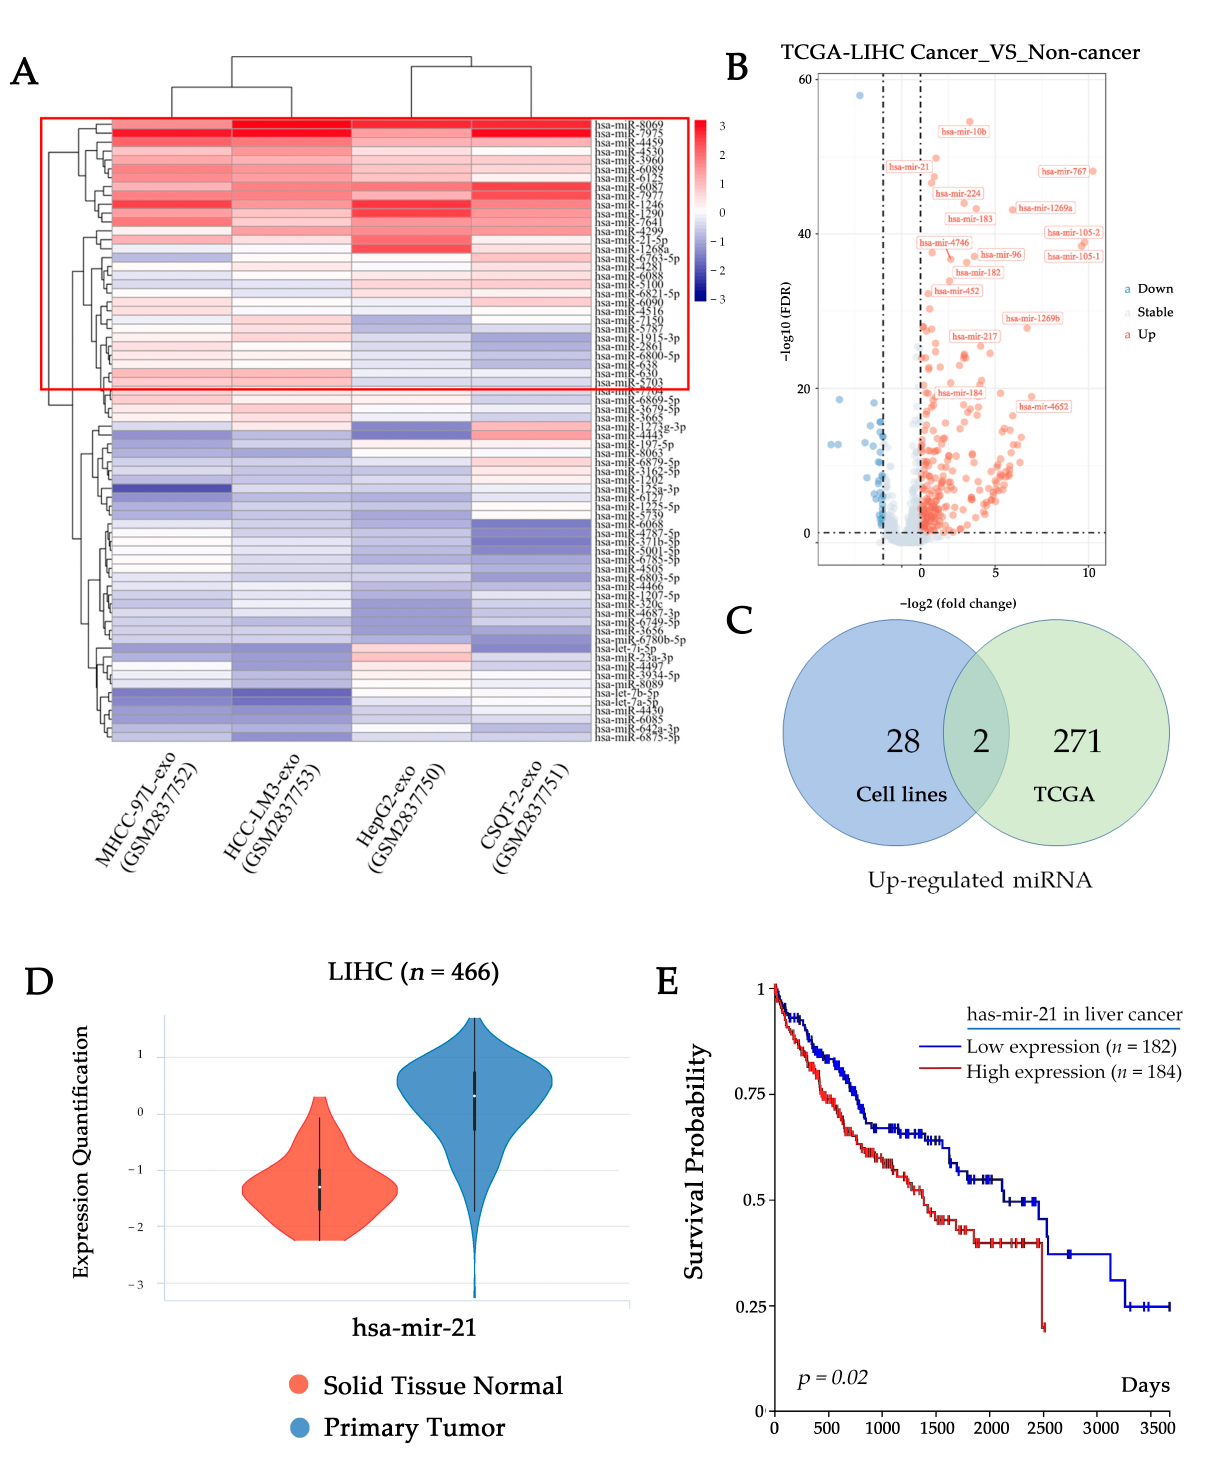
Figure 3. HCC-derived exosomes contain large amounts of miR-21-5p. ( A ) Heatmap shows top 30 miRNA (in the red box) in HCC cell line-derived exosomes (GSE106452). ( B ) Volcano plot shows differentially expressed miRNAs in TCGA LIHC dataset. ( C ) Venn diagram shows the intersection of up-regulated miRNA in GES106452 and TCGA LIHC datasets. ( D ) Violin plots show the expression of mir-21-5p in different types of tissue in TCGA LIHC. ( E ) Overall survival curves of TCGA LIHC data indicate the relationship between miRNA expression level and patient